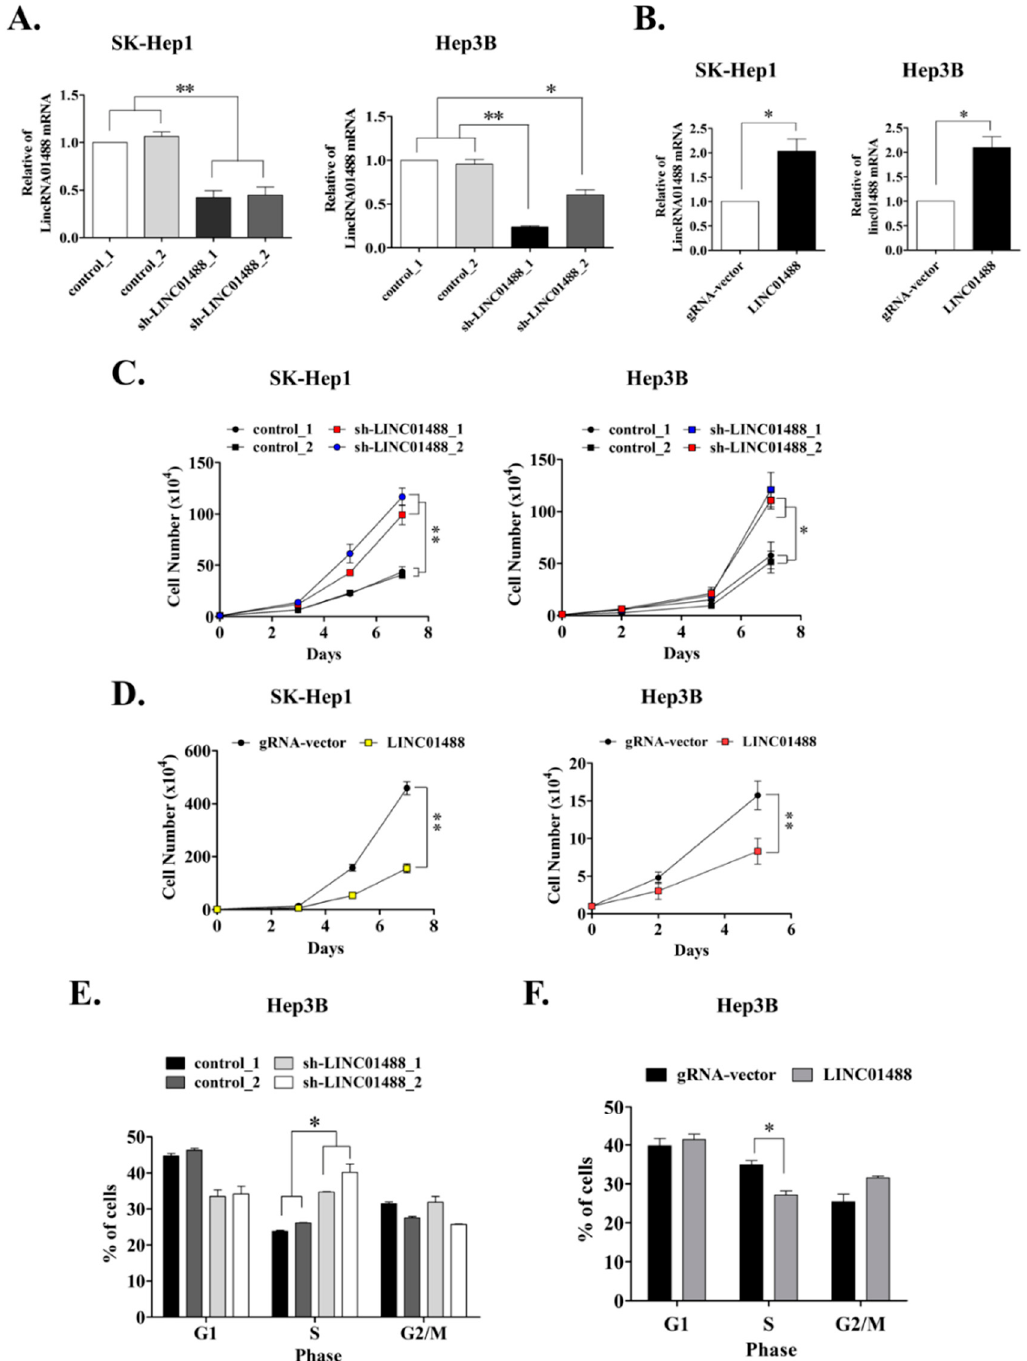
Figure 2. Proliferative ability was enhanced upon knockdown of LINC01488 in vitro. ( A ) Knockdown and ( B ) overexpression of LINC01488 in SK-Hep1 or Hep3B cell lines followed by q-RT-PCR analysis. ( C ) Knockdown of LINC01488 promotes proliferation of SK-Hep1 and Hep3B cells. ( D ) Overexpression of LINC01488 inhibits cell growth. ( E ) FACS analysis of the cell cycle. Depletion of LINC01488 promoted Hep3B cell arrest in the S phase. ( F ) Overexpression of LINC01488 in Hep3B inhibited the S phase of cells. Data are presented as means ± SD (* p < 0.05; ** p < 0.01).